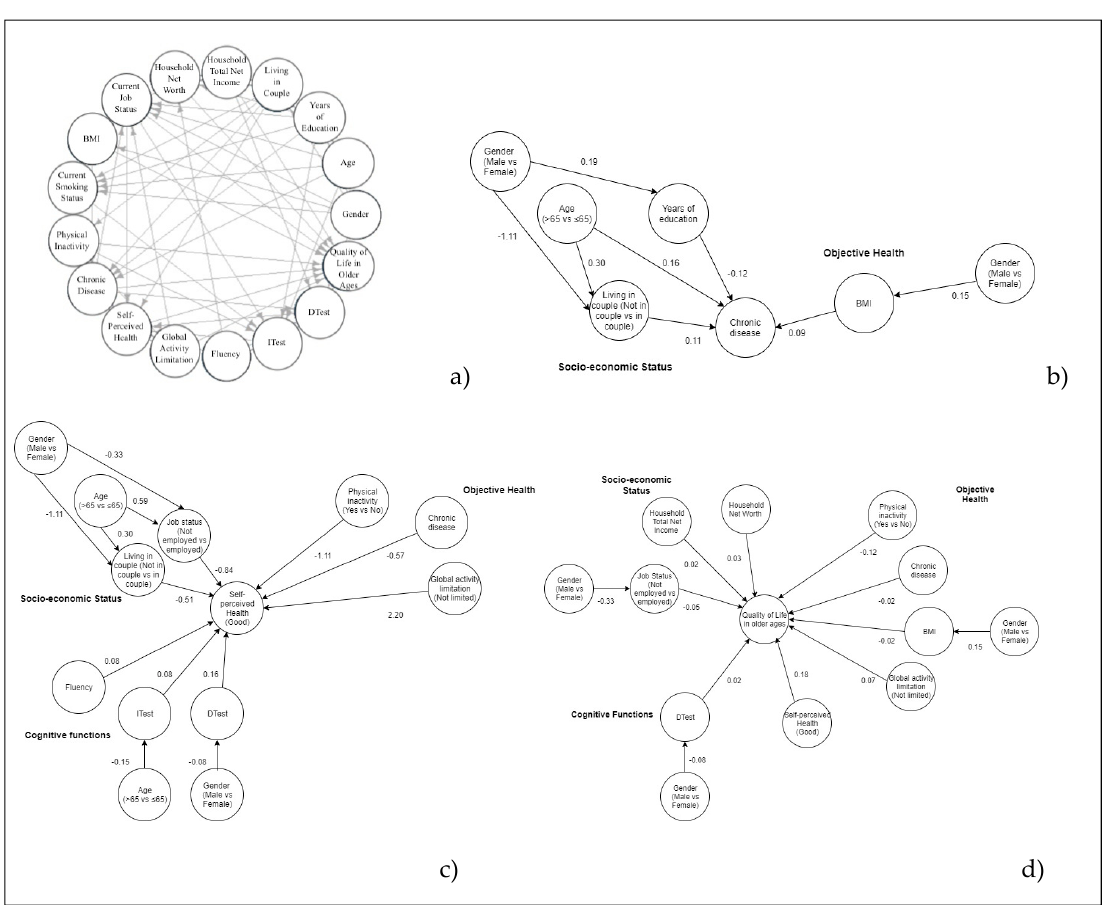
DTest and living in a couple for Greek and Italian DAGs.